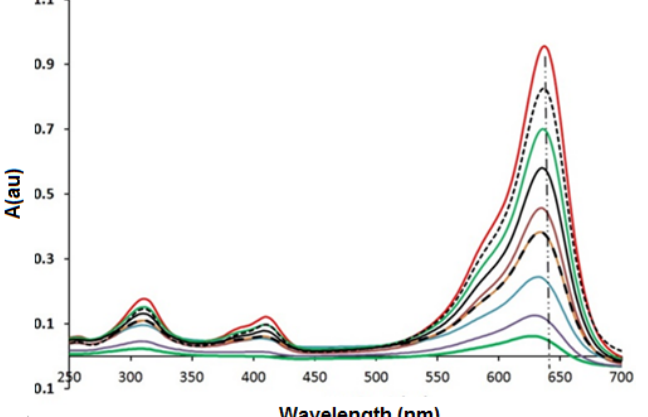
Fig. 7. Variation of the absorbance as a function of time for various Cu doped TiO Fig.7 Variation of the absorbance as a function of time for various Cu doped TiO 2 samples prepared in two different media.